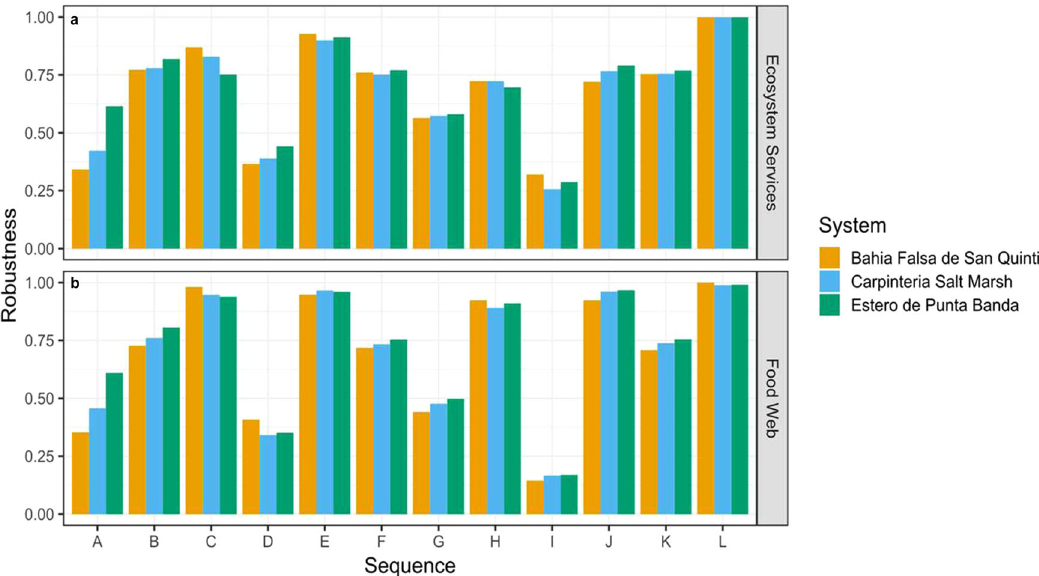
Fig. 7 Ecosystem service and food web robustness vary across species loss sequences. a ecosystem service robustness values and b food web robustness across the following species loss sequences: (A) Ecosystem service providers: high-to-low biomass, (B) ecosystem service providers: random mean, (C) ecosystem service providers: low-to-high biomass, (D) most-to-least connected, (E) random; maximum, (F) random; mean, (G) random; minimum, (H) rarity, (I) supporting species: most to least important, (J) supporting species: least-to-most important, (K) supporting species: random mean, (L) vulnerable